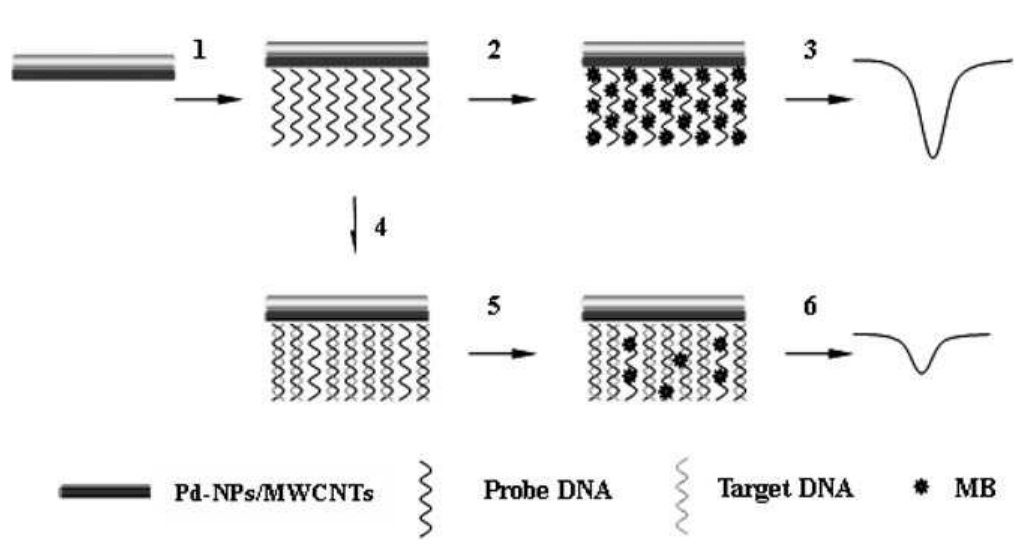
Figure 5. Schematic representation of the electrochemical detection of DNA hybridization based on Pd nanoparticles (Pd-NPs) combined MWCNTs. Reproduced with permission from [90].